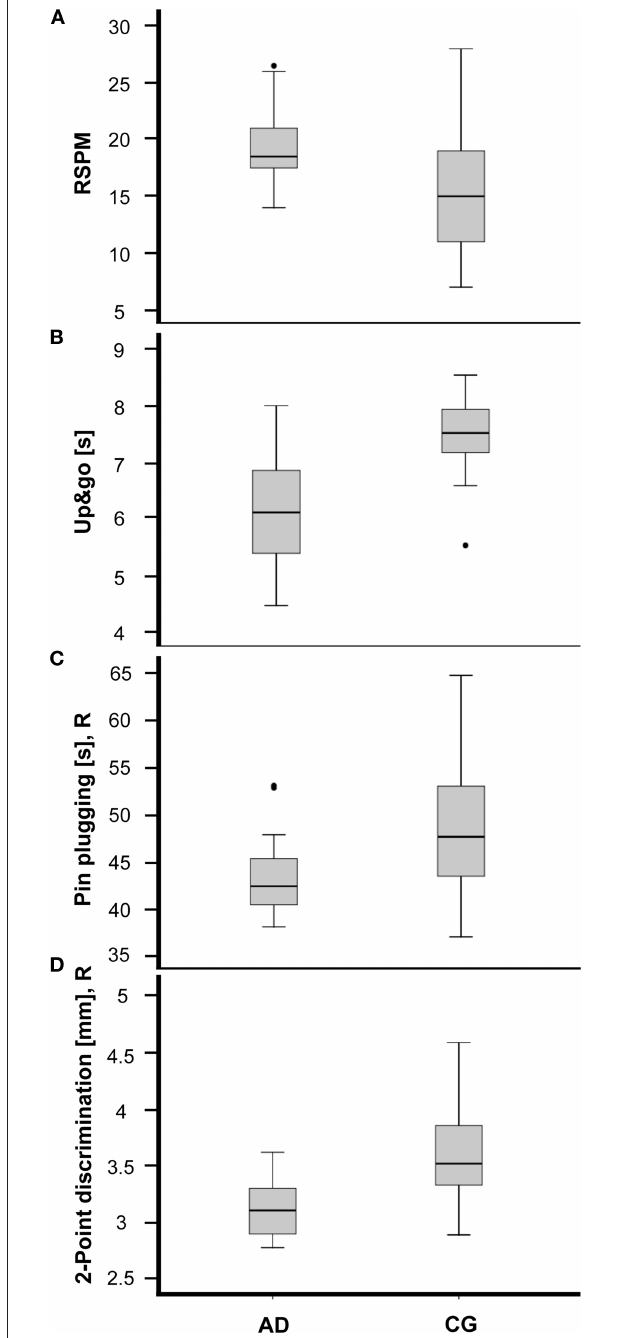
FiGuRE 1 | Performance of amateur dancers (AD) and a matched control group (CG) for selected tests covering cognitive, posture&balance, motor and tactile domains. Participants of the AD group showed (A) higher scores in the RSPM ( p = 0.015), (b) shorter Up&go times ( p = 0.013), (C) shorter task completion times ( p = 0.305) in the Pin plugging test (right hand), and (D) lower 2-Point-discrimination threshold (right index finger) ( p = 0.002). The horizontal lines within the boxes represent the medians. Boxes show the top and bottom quartiles and whiskers represent the minima and maxima within 1.5 interquartile range (IQR). Outliers ( > 3.0 IQR) are labeled as solid